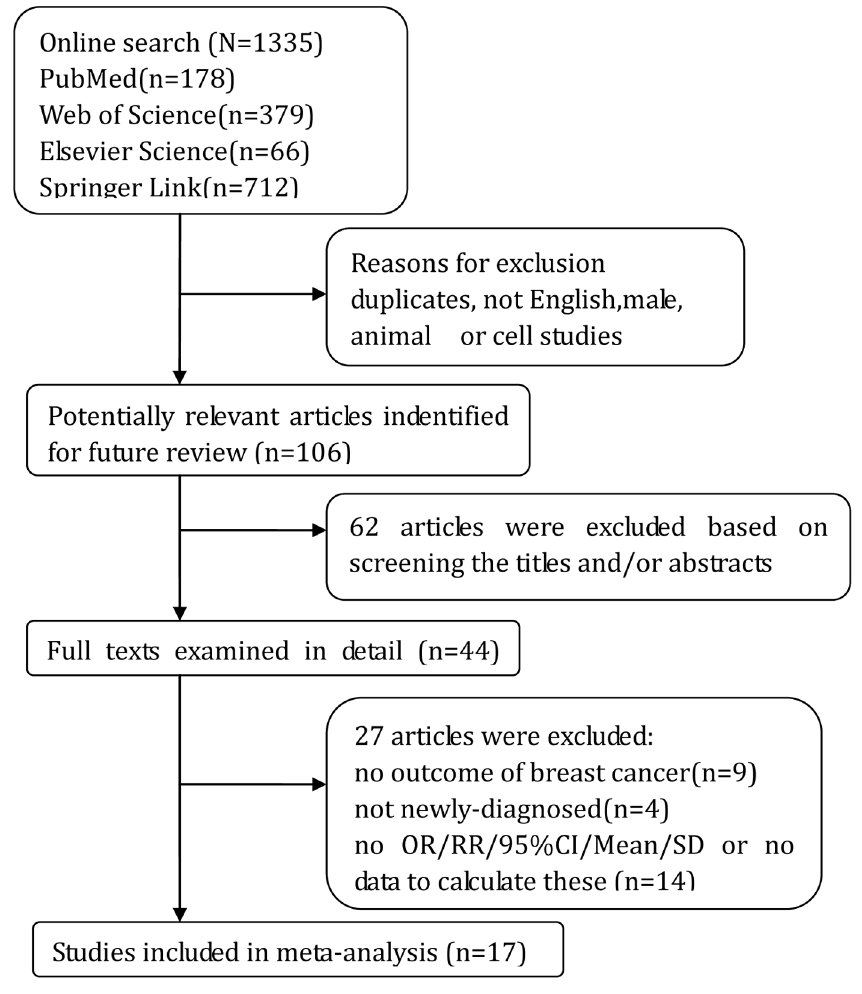
Figure 1. Flow diagram of the study selection process. doi: